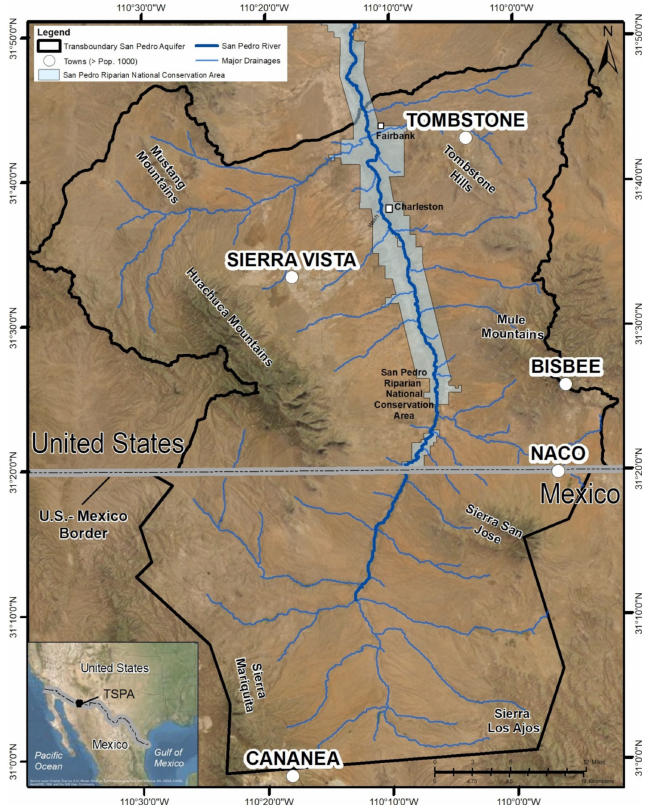
Figure 1. The Transboundary San Pedro Aquifer (TSPA). Source: Authors’ development based on Callegary et al. (2016) [24]. Table 1. Population centers located in the TSPA. Source: INEGI, 2010, INEGI, 2020, U.S.